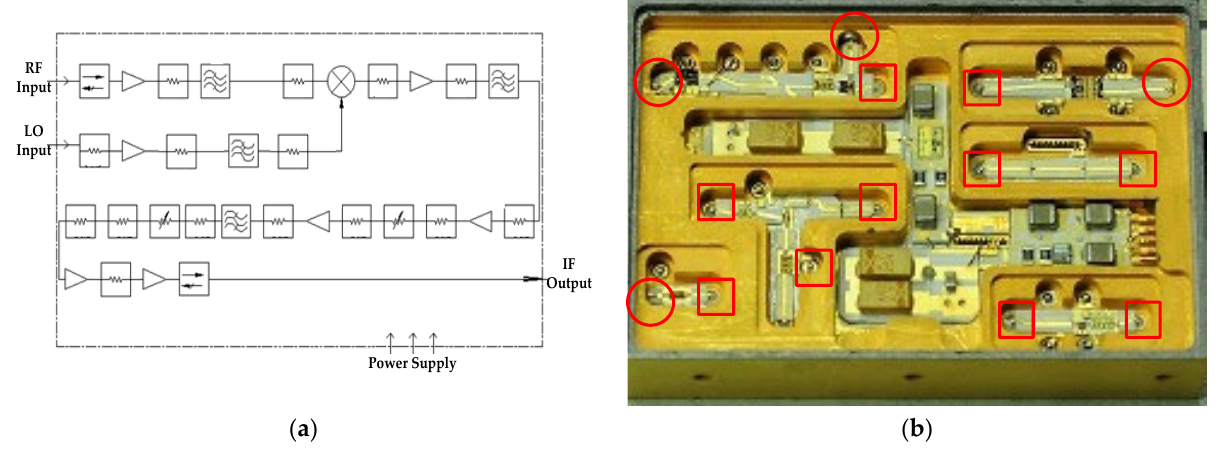
Figure 24. Schematic diagram and photo of the Ka band receiving SIP. ( a ) Schematic diagram of the receiving SIP; ( b ) Photo of the receiving SIP.